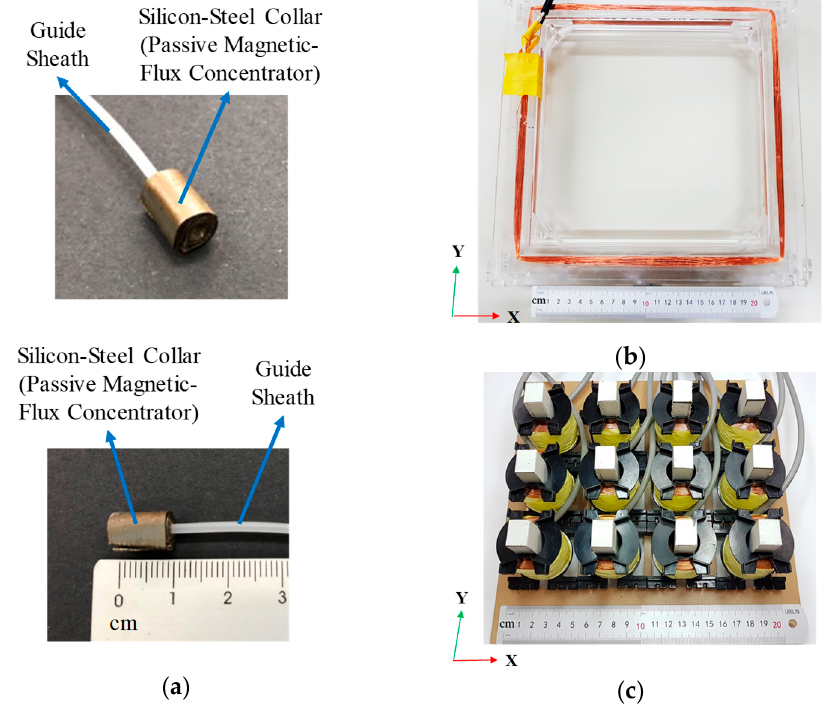
Figure 5. The fabrication results of major components of the system: ( a ) the passive magnetic-flux concentrator (i.e., the high permeability silicon-steel collar) fixed onto a guide sheath, ( b ) the emitting coil, ( c ) the receiving electromagnets-array.